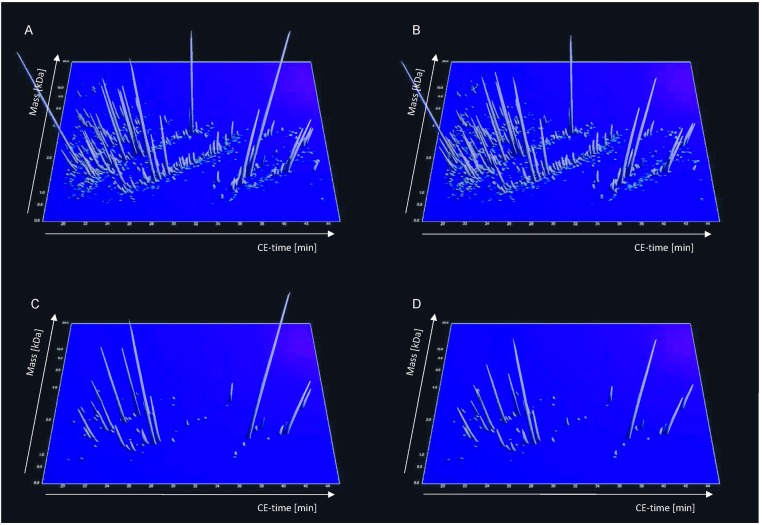
Urinary polypeptide patterns of control and individuals with ACS.Panels A and B: Compiled polypeptide patterns of the controls and individuals with ACS events during follow up after urine sampling examined in the training set; the molecular mass (0.6–20 kDa, on a logarithmic scale) is plotted against normalized migration time (18–45 min). Signal intensity is encoded by peak height and colour. Panels C and D: Distribution of potential biomarkers for ACS in controls and individuals with ACS events during follow up after urine sampling based on the ACS-specific peptide biomarker pattern. All statistically significant biomarkers are shown.